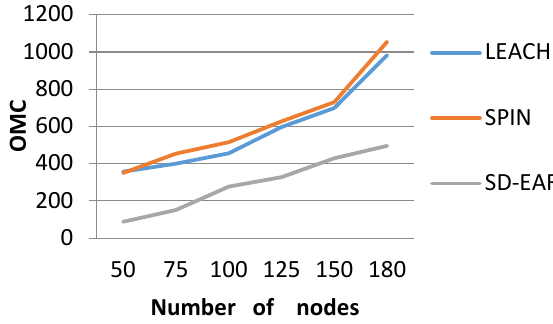
Figure 11. Overall Message Cost (OMC) vs. number of nodes.